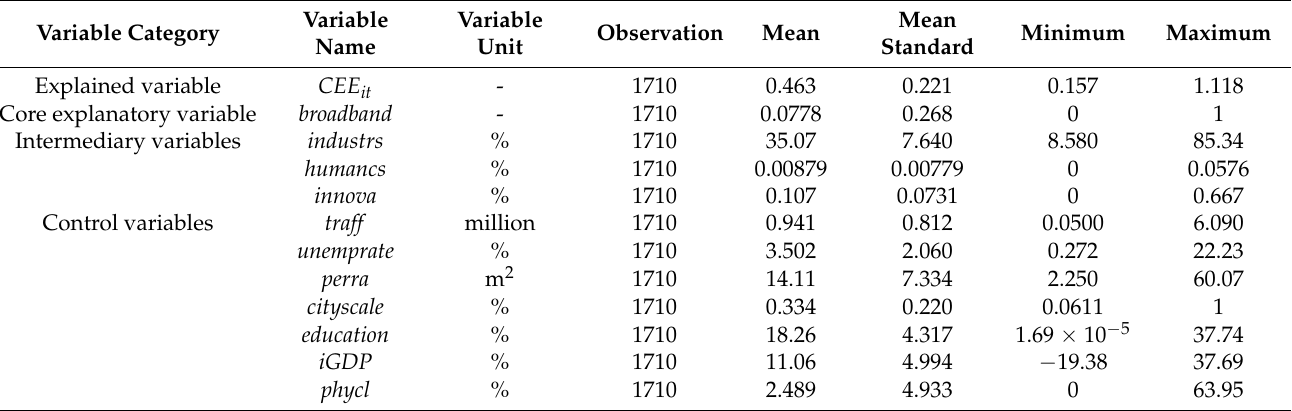
Table 2. Descriptive statistics of